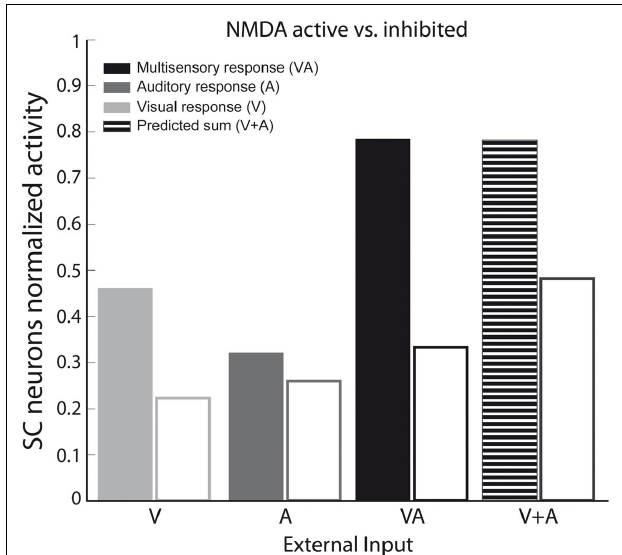
FIGURE 8 | Unisensory and multisensory responses with NMDA receptors active or inhibited. Activity was assessed by presenting to the network auditory (dark-grey bars), visual (light-grey bars) and multisensory (black bars) inputs (with a high level of intensity, I = 50), at the center of the RF both with NMDA receptors active (fi lled bars) and inhibited (empty bars). It is worth noting that the visual response is more affected (50%) by the NMDA inhibition than the auditory one, and the cross-modal response is reduced more than the sum of the unimodal